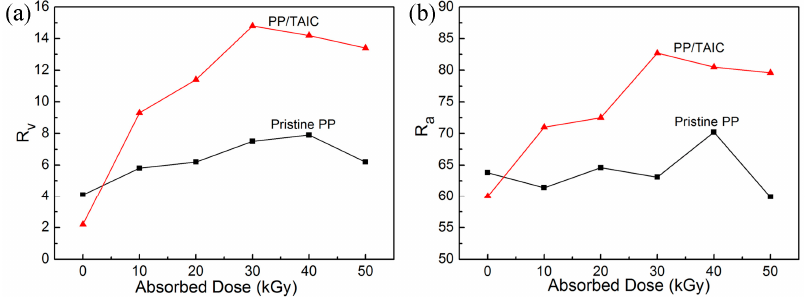
Figure 7. Dose dependence of ( a ) volume expansion ratio (R v ) and ( b ) foaming rate (R a ) for pristine PP and PP/TAIC (2 wt %) foams prepared at 152 °C and 20 MPa.